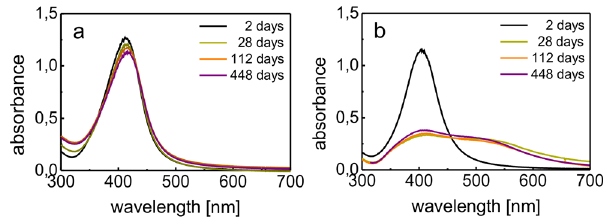
Figure 2. UV/vis absorption spectra of AgNPs reduced by maltose (a) and sodium borohydride (b) and modified by gelatin at a concentration of 0.01% (w/w) in the reaction system.